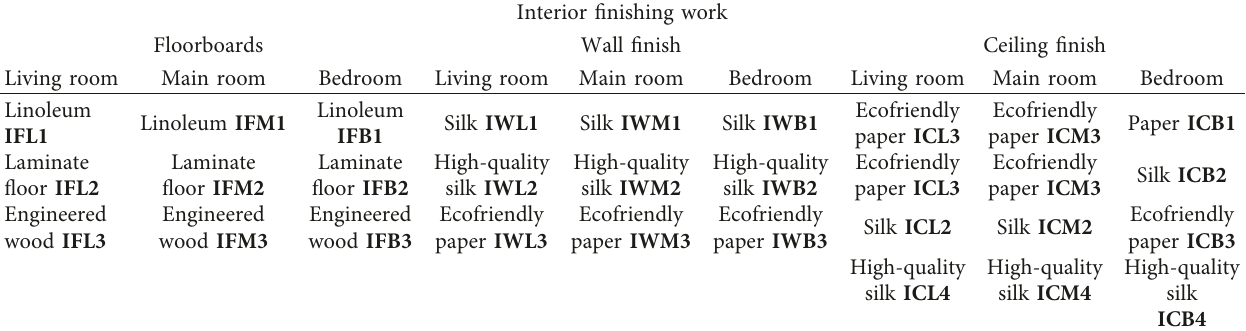
Table 6: Combination matrix (interior finishing work).